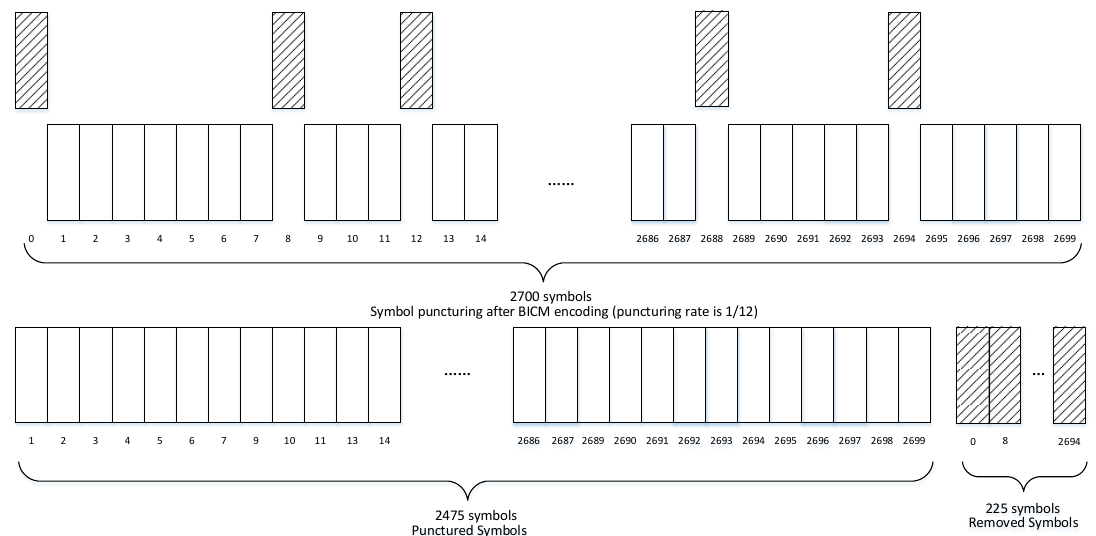
Figure 6. The schematic diagram of the non-equal interval symbol puncturing (NEISP) after BICM encoding in the LDM-Ex-FDM scheme.